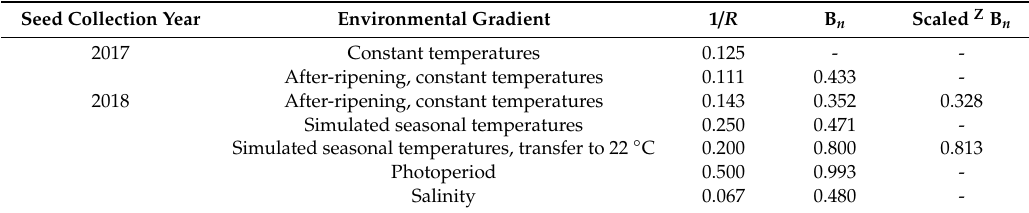
Table 5. Germination niche breadth (B n ) for Linum arenicola seeds exposed to multiple environmental factors.